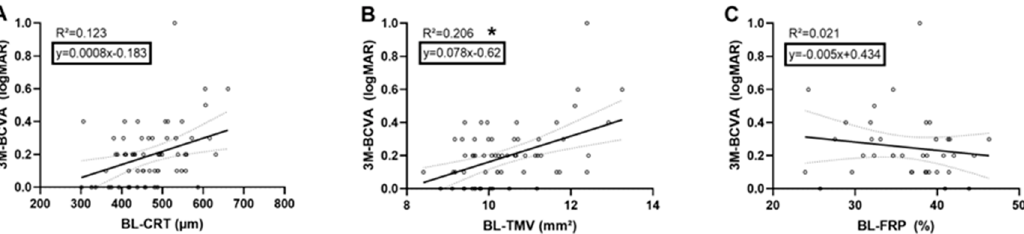
Figure 2. Linear regression model showing the 3-months (3M) best corrected visual acuity (BCVA) dependency of each central retinal thickness (CRT) ( A ), total macular volume (TMV) ( B ), and full retinal perfusion (FRP) ( C ) at baseline (BL). Black line represents the linear regression line; dotted line shows the upper and lower bound of the 95% confidence interval. * signifies p < 0.05.